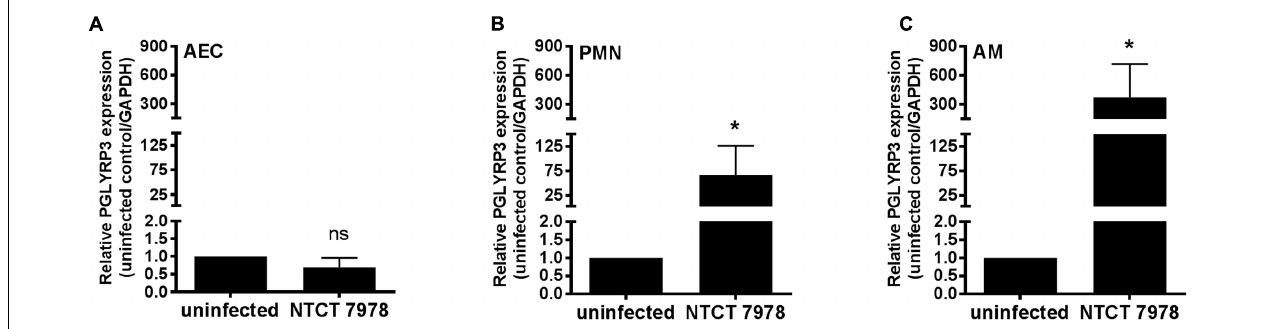
FIGURE 1 | Pneumococcus-dependent expression of PGLYRP3 in primary cells. The PGLYRP3 expression in isolated primary mouse cells from wt mice was obtained by qPCR. Six hours after in vitro stimulation with S. pneumoniae (NCTC 7978; MOI 1) PGLYRP3 expression was unchanged in alveolar epithelial cells